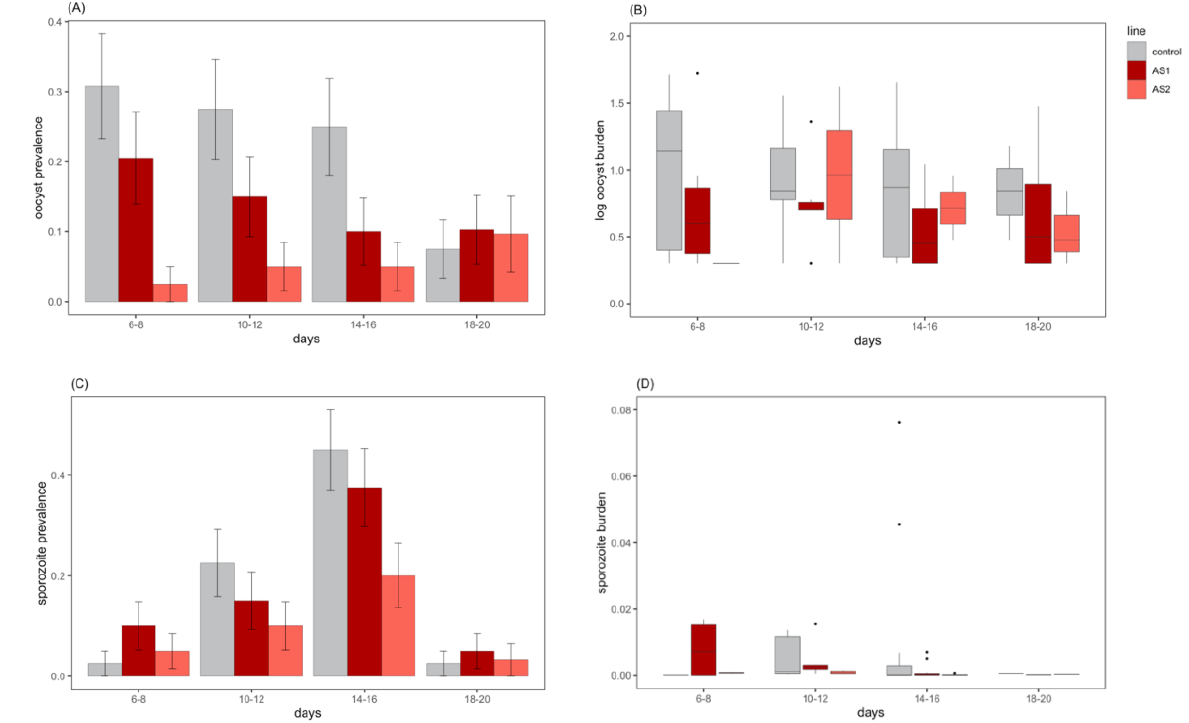
Figure 6. Experiment 3. Oocyst prevalence (A) and burden (B), sporozoite prevalence (C), and burden (D) of mosquitoes infected by each of the parasite lines for different sampling intervals. Prevalence is represented as the mean ± standard error (calculated as sqrt(pq/n)). Oocyst and sporozoite burden are represented as a boxplot with the median (horizontal lines), first and third quartiles (box above and below the medians). Vertical lines delimit 1.5 times the inter-quartile range above which individual counts are considered outliers and marked as